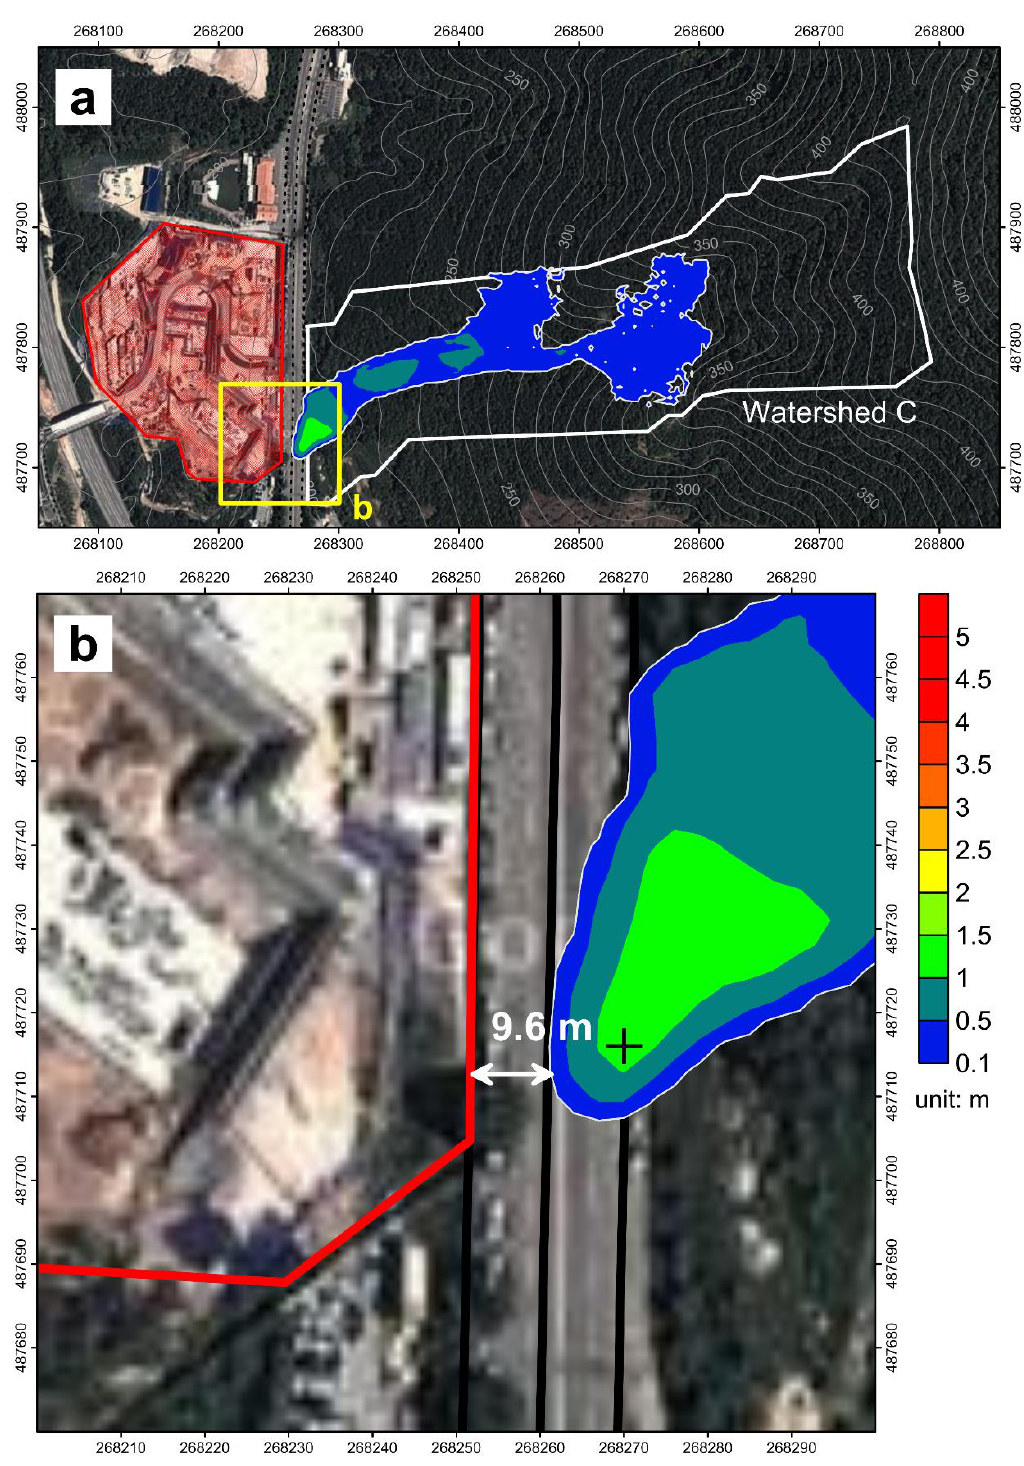
Figure 14. ( a ) Final deposition of debris in Watershed C. ( b ) Distance from the front of the final deposition to the site boundary.